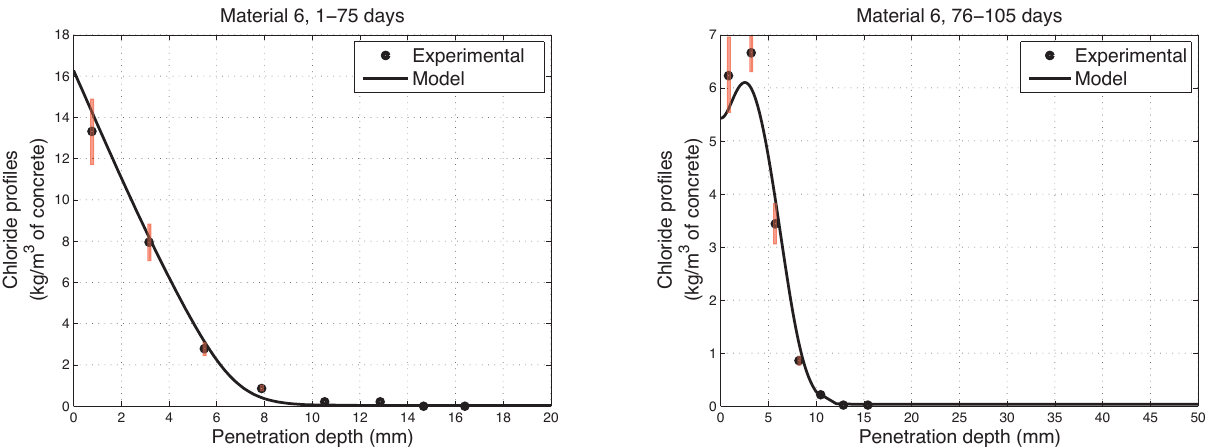
Figure 8. Experimental versus numerical solution for material mat6 and environments 1 (1–75 days) 2 (76–105 days).